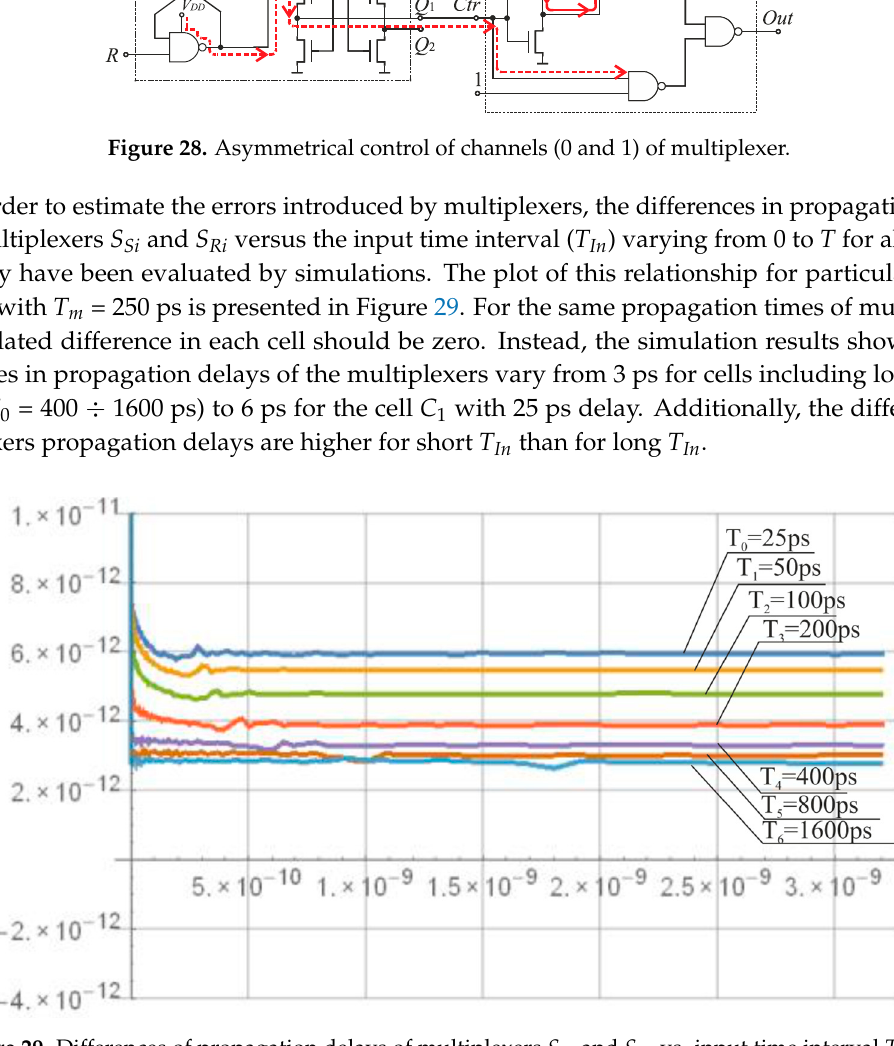
Figure 28. Asymmetrical control of channels (0 and 1) of multiplexer.